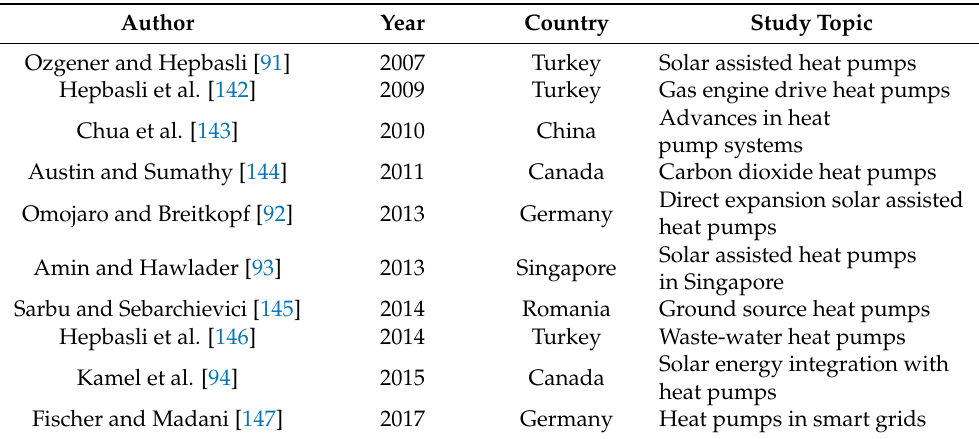
Table 4. Summary of previous heat pump study